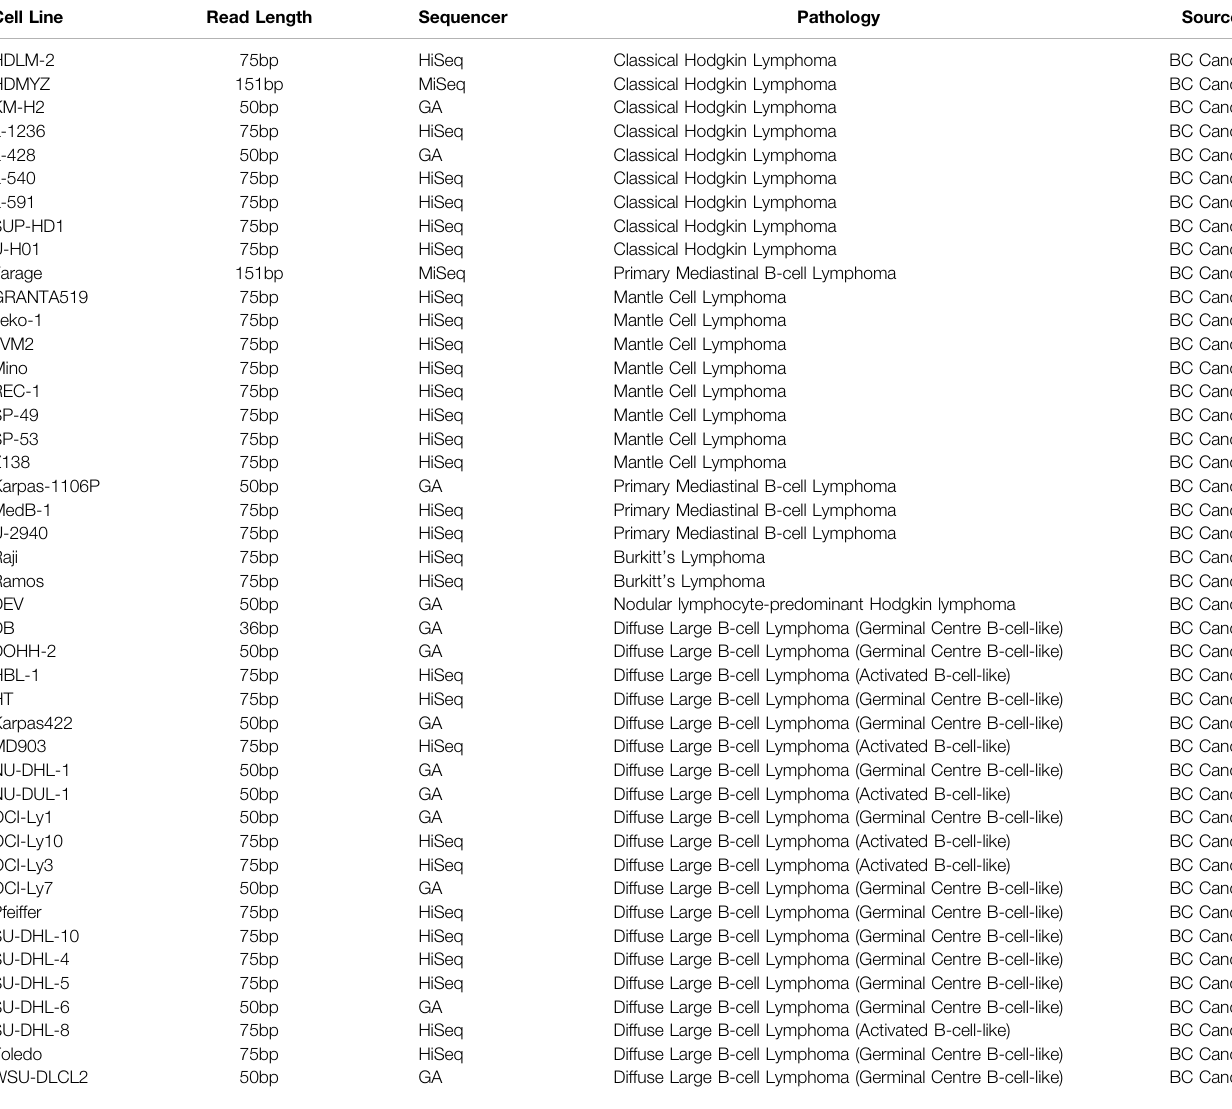
TABLE 1 | Sequencing conditions used for RNA sequencing of lymphoma cell lines. Cell lines of various pathologies were included for analysis. Cell